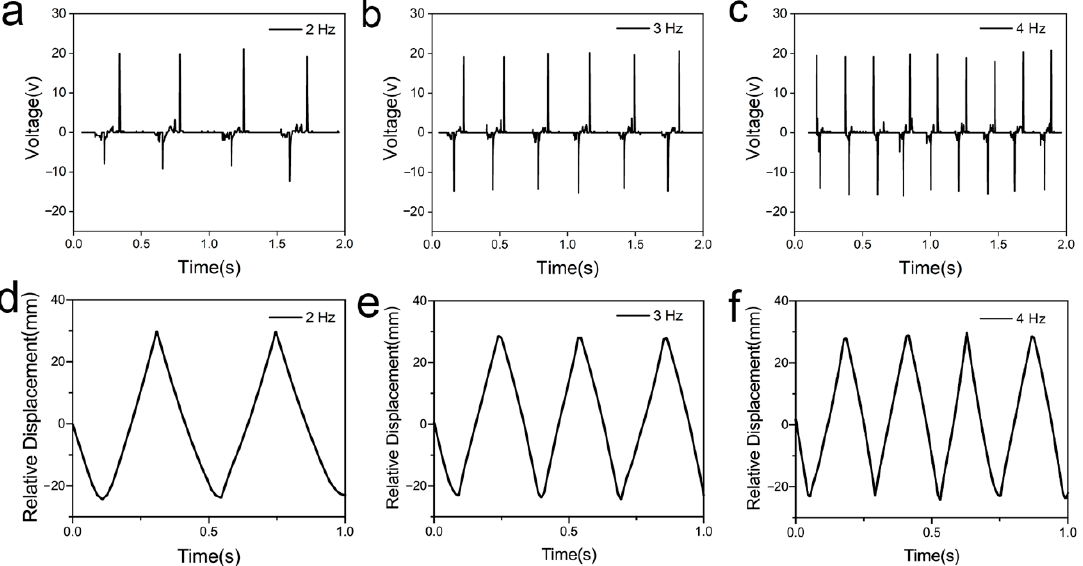
Figure 3. Output voltage signals and relative displacement at different vibration frequency from 2 Hz to 4 Hz and same amplitude of 30 mm. ( a ) Output voltage signal when the vibration frequency is 2 Hz. ( b ) Output voltage signal when the vibration frequency is 3 Hz. ( c ) Output voltage signal when the vibration frequency is 4 Hz. ( d ) Relative displacement when the vibration frequency is 2 Hz. ( e ) Relative displacement when the vibration frequency is 3 Hz. ( f ) Relative displacement when the vibration frequency is 4 Hz.